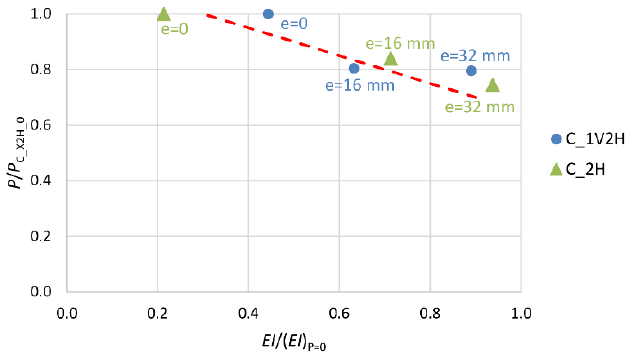
Figure 10. Change in sti ff ness of specimens with two layers of transverse composite reinforcement Figure 10. Change in stiffness of specimens with two layers of transverse composite reinforcement Figure 10. Change in stiffness of specimens with two layers of transverse composite reinforcement Figure 10. Change in stiffness of specimens with two layers of transverse composite reinforcement (X—number of layers of longitudinal composite reinforcement V: 0 or (X—number of layers of longitudinal composite reinforcement V: 0 or 1). (X—number of layers of longitudinal composite reinforcement V: 0 or 1). (X—number of layers of longitudinal composite reinforcement V: 0 or 1).